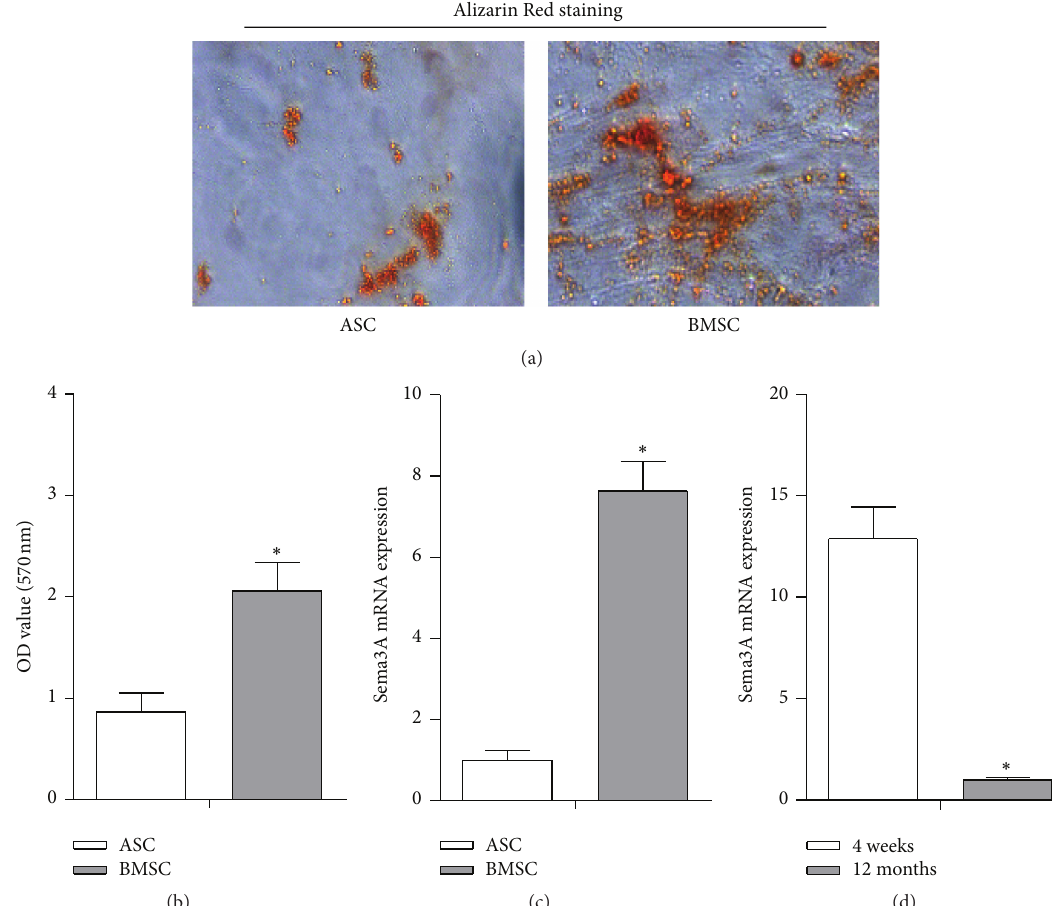
Figure 1: High expression of Sema3A correlates with the potent osteogenic capacity in BMSCs. (a) ASCs and BMSCs from the same rat were cultured in the osteogenic medium and significantly less mineralization nodules were found in ASCs than that in BMSCs after 21 days of osteogenic induction. (b) Quantification data of ECM mineralization in Figure 1(a). (c) Sema3A expression was significantly less in ASCs than that in BMSCs, as detected by qPCR. (d) Lower Sema3A expression was also found in 12-month rat derived BMSCs, compared with that from 4-week rat derived BMSCs. Mean ± SD, 𝑛 = 3 , and ∗ 𝑝 < 0.05 . Sema3A, semaphorin 3A; ECM, extracellular